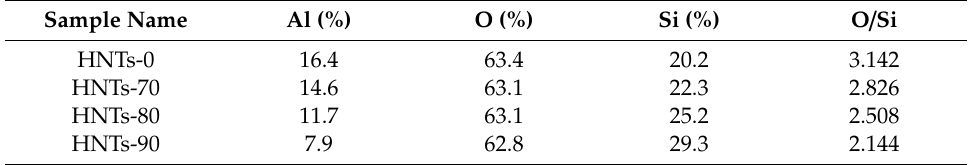
Table 1. Surface chemical composition of HNTs with di ff erent etching temperature by XPS analysis.